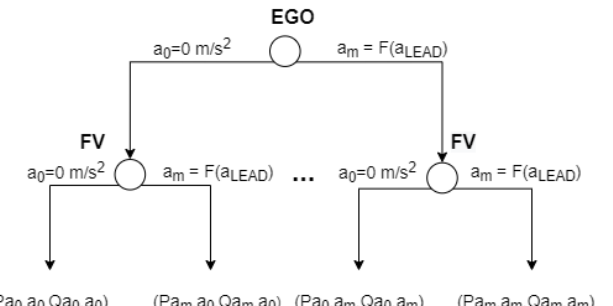
Figure 12. Dynamic noncooperative game description in its extensive-form representation. EGO and FV denote the players; a 0 and a m denote their respective sets of strategies. Pxy and Qxy denote the outcome of the game, where x is the FV’s selected strategy and y is the strategy selected by